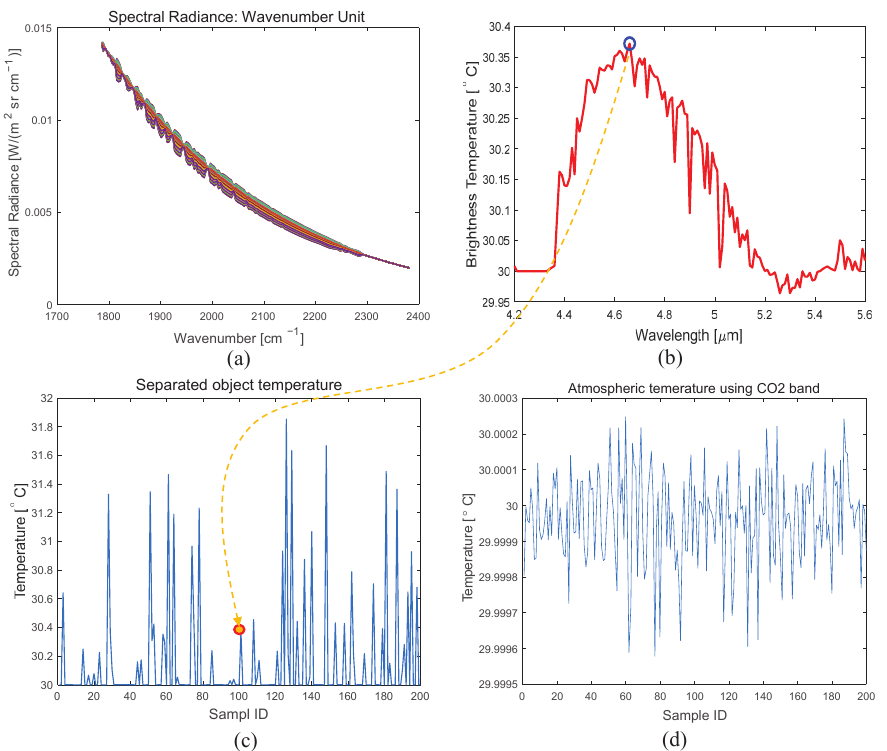
Figure 15. Temperature separation from synthetic spectra: ( a ) generated synthetic data (200 spectra), ( b ) brightness temperature and peak value for a sample spectrum, ( c ) the distribution of separated object temperatures, and ( d ) the distribution of separated atmospheric temperatures using the CO 2 absorption band.